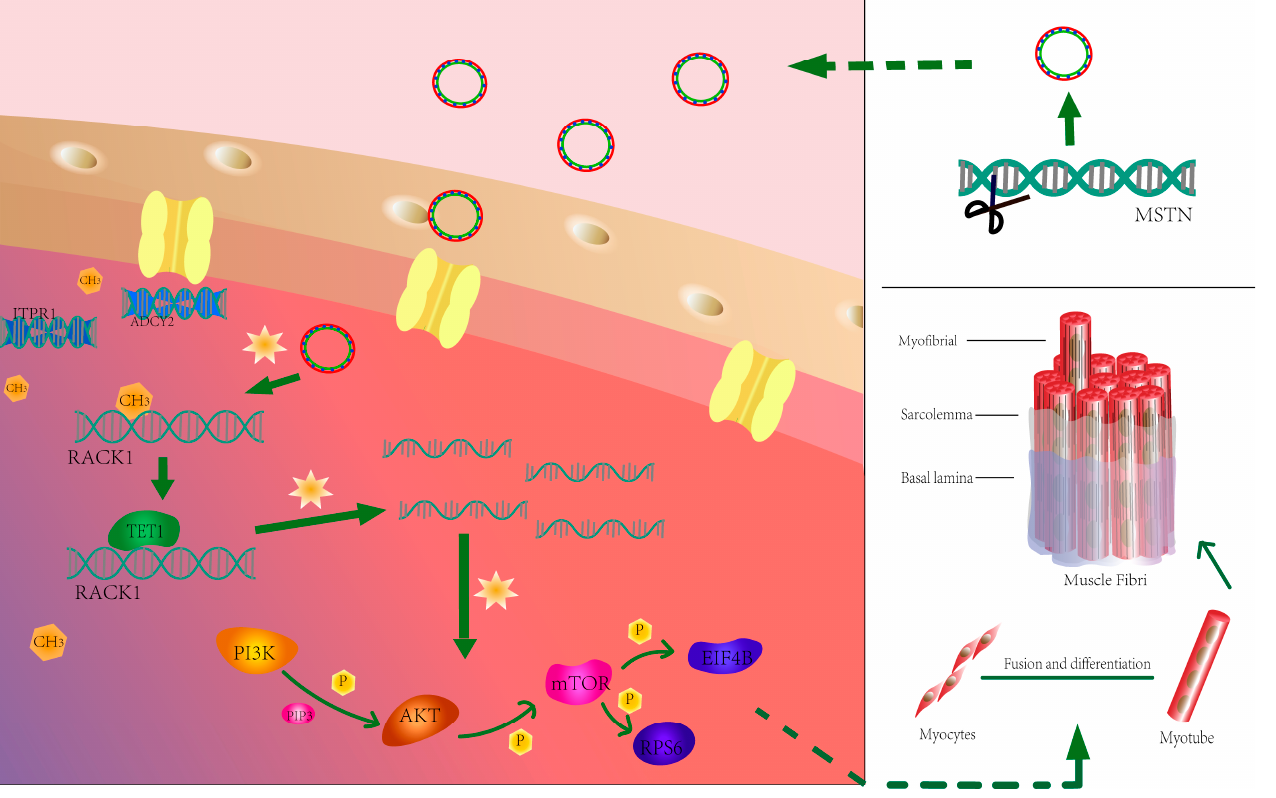
Figure 9. Myostatin regulates the molecular mechanism of myogenic differentiation by reducing DNA methylation. The upper right panel shows that knockdown of myostatin was achieved by constructing site-mutated vectors to transfect cells. The present work shows that deletion of myostatin triggers a decrease in global DNA methylation and promotes binding of the enzyme TET1 to the RACK1 promoter region, leading to hypomethylation and increased transcription in the RACK1 promoter region. Increased RACK1 promotes myogenic differentiation of bovine skeletal muscle satellite cells via activation of the PI3K/AKT/mTOR pathway.